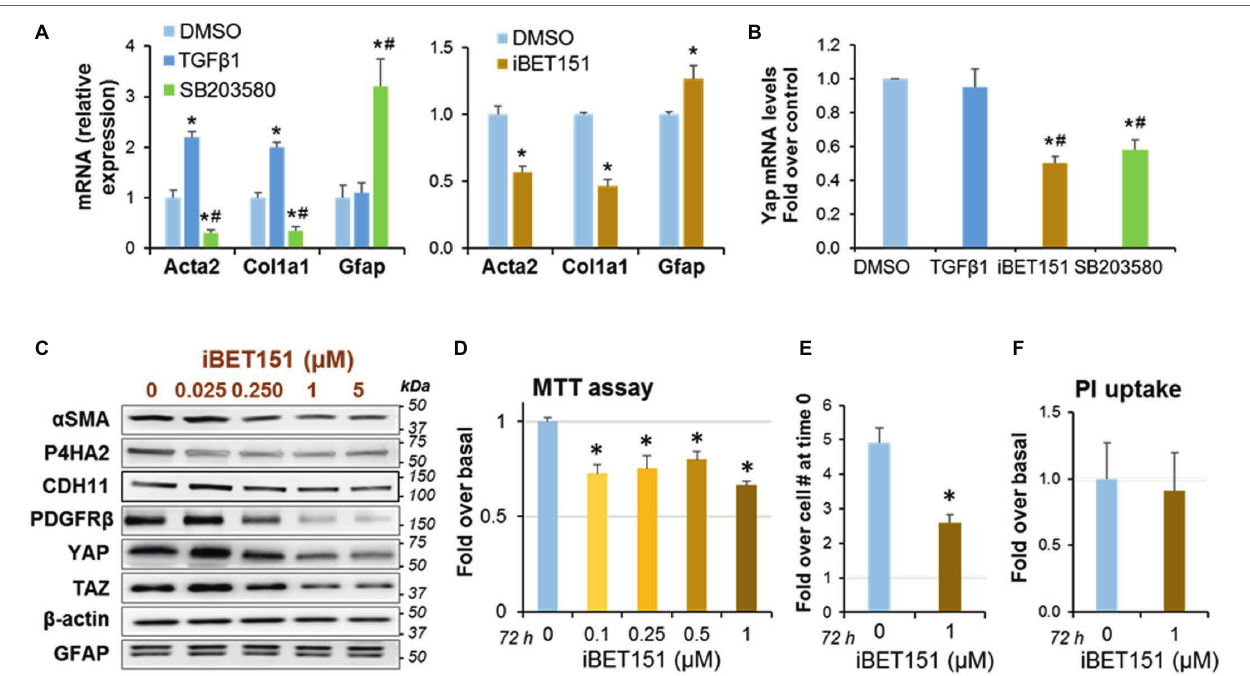
FIGURE 3 | PaSC quiescence induced by a p38 MAP Kinase inhibitor or a BET family inhibitor is associated with YAP downregulation. Immortalized mouse PaSC (imPaSC) were treated with DMSO (control), the p38 MAPK inhibitor SB203580 (5 μ M) or the BET inhibitor iBET151 (1 μ M) for different times. In selected experiments, TGF β 1 (5 ng/ml) was used as positive control to induce upregulation of proteins found increased in activated PaSC ( α SMA and Col1a1). (A,B) Graphs show mRNA levels of Acta2 ( α SMA), Col1a1, GFAP (a marker of quiescent PaSC) and YAP measured by qPCR in imPaSC treated for 24 h with the indicated agents. Data is representative of three independent experiments. * p < 0.05 vs. DMSO; # p < 0.05 vs. TGF β 1 treatment. (C) Protein extracts from imPaSC treated for 24 h with different concentrations of iBET151 were analyzed to determine levels of YAP and TAZ and the indicated PaSC markers; representative immunoblots are shown. β -actin was used as loading control. As shown, BET inhibition decreases protein levels of several markers of PaSC activation but does not affect levels of the quiescent marker GFAP. Data is representative of three independent experiments. (D–F) imPaSC were treated for 72 h with iBET151 at the indicated concentrations, and metabolic activity (MTT assay), cell number and cell necrosis (PI uptake) were assessed. Additionally , Supplementary Figure S2A shows protein levels of caspase-3 as a marker of caspase-dependent apoptosis . (D) Graph shows MTT assay data after 72 h treatment. (E) Graph shows number of imPaSC after 72 h treatment with or without 1 μ M iBET151. The number of cells at 0 and 72 h were assessed by trypan blue exclusion using a hemocytometer; data are expressed as fold increase over the cell number at time 0 (1.25 × 10 4 ). (E) PI uptake was measured as indicated in “Materials and Methods” section. Graphs show * p < 0.05 vs. no-iBET151 control. Data in graphs (D–F) represent the means ± SD; n =